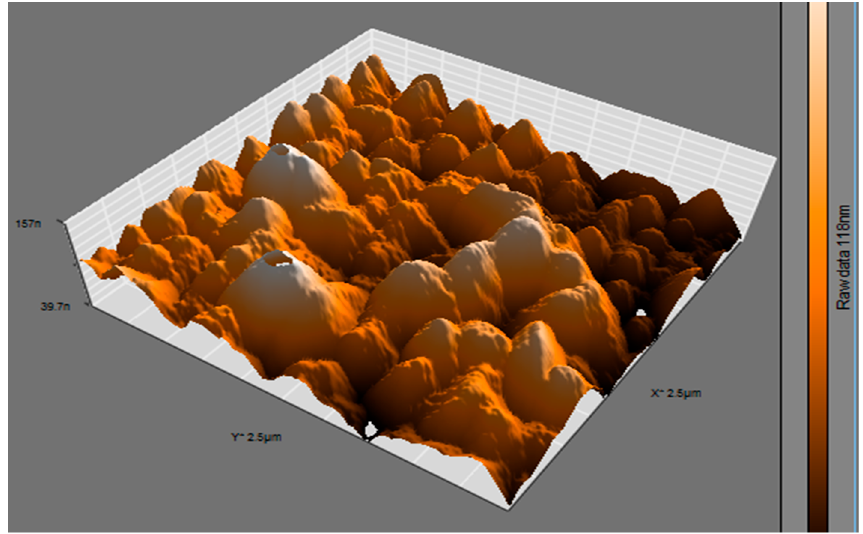
Figure 3. 3-D AFM image of ZnPc thin film.